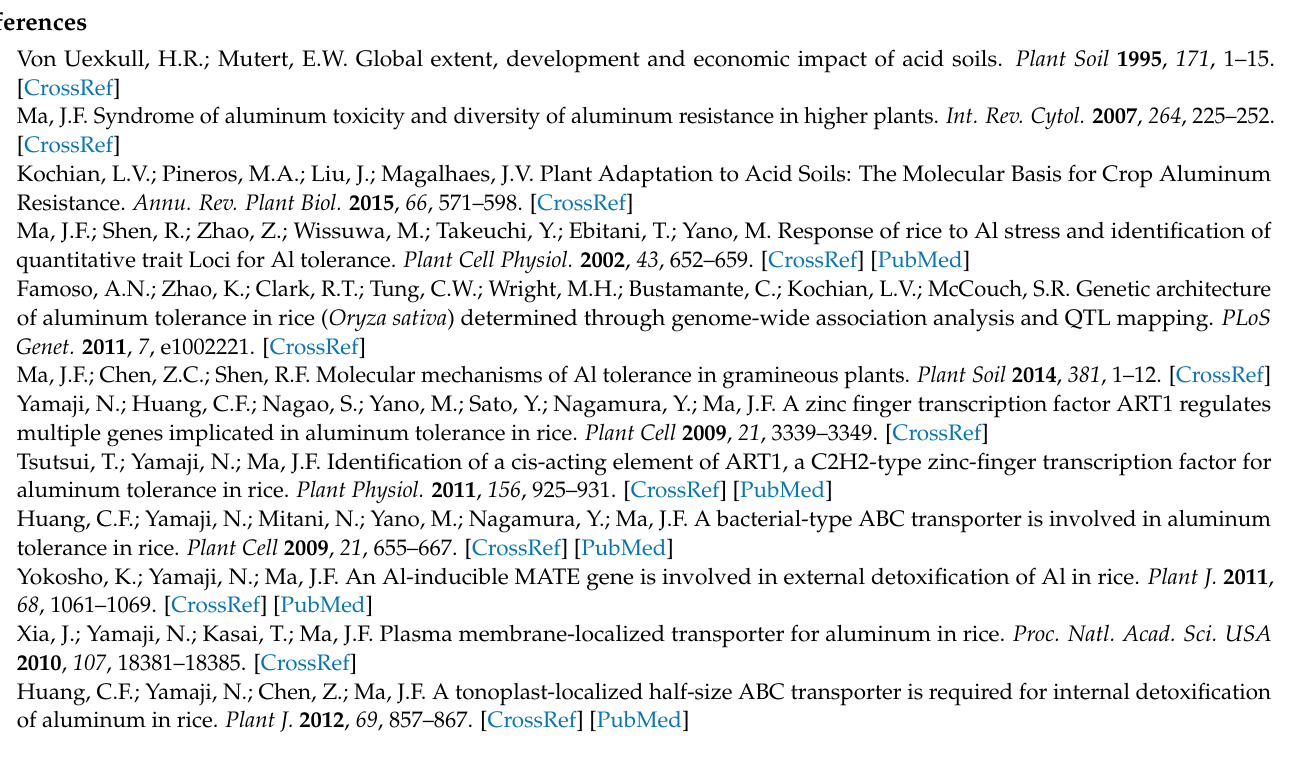
Figure S2. Correlation of the gene expression ratio between RNA-seq data and quantitative real-time PCR (qRT-PCR) results. Supplementary Figure S3. Sequence comparison of the promoter (a) and coding sequence (CDS) regions (b) of ART1 between Kasalath and Jinguoyin. Supplementary Table S1 Primer sequences used for investigating gene